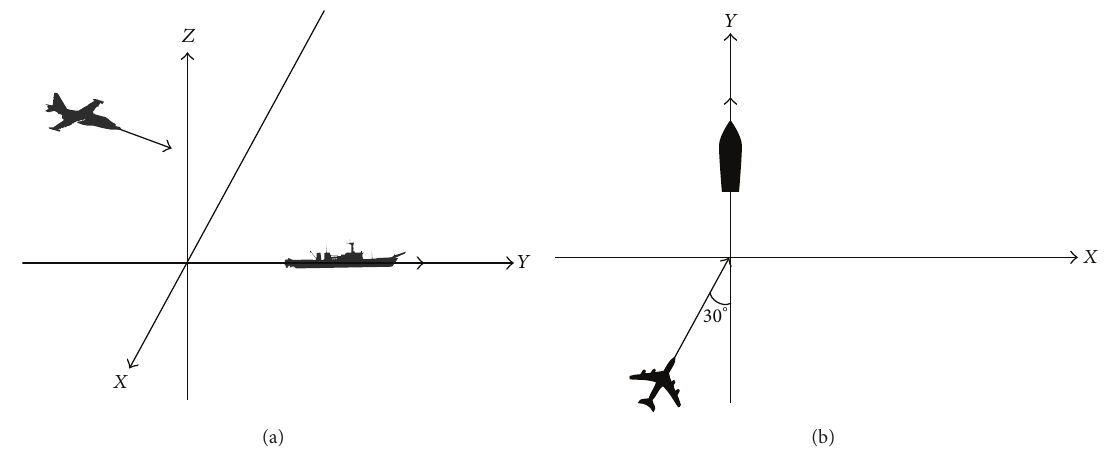
Figure 9: Simulation scenarios of Case 2 for (a) 3D and (b) top view diagrams.